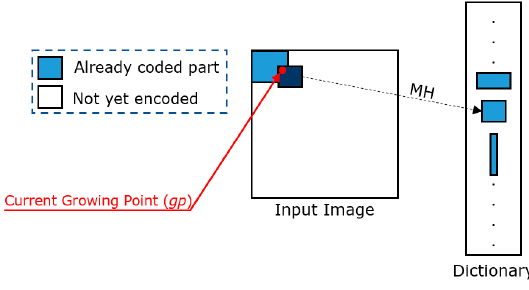
Figure 5. Examples of matching heuristics.